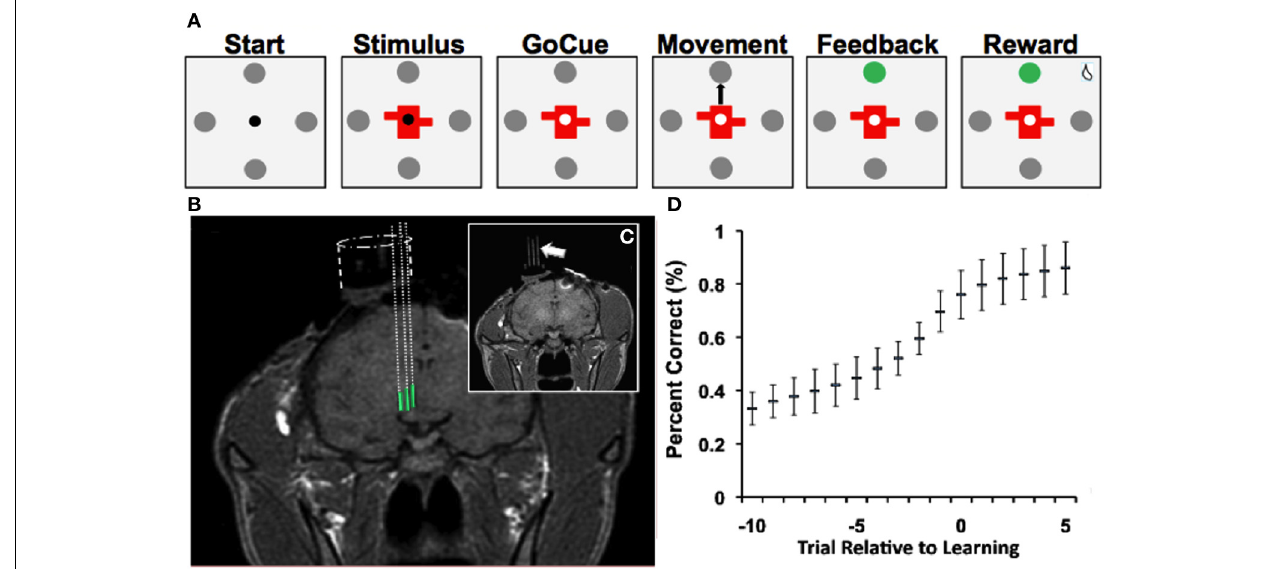
FIGURE 1 | Learning task, recordings and learning. (A) Depiction of visual-motor learning task. Each trial began (“Start”) with the presentation of a central fixation point (0.2 ◦ diameter) surrounded by four gray targets (1 ◦ diameter and 10 ◦ from the center). Animals were required to fixate within 2 ◦ of the fixation point for 500ms. Then either a novel or familiar stimulus appeared for 500ms at the center, with the fixation point still visible (“Stimulus”). After a variable delay of 500–1000ms, the fixation point disappeared (“Go-Cue”), at which point the monkey was allowed to saccade from the center of the screen to one of the four targets (“Movement”). Once the animal fixated on a target for 500ms, an auditory tone (“Feedback/Tone”) and a color change of the selected target